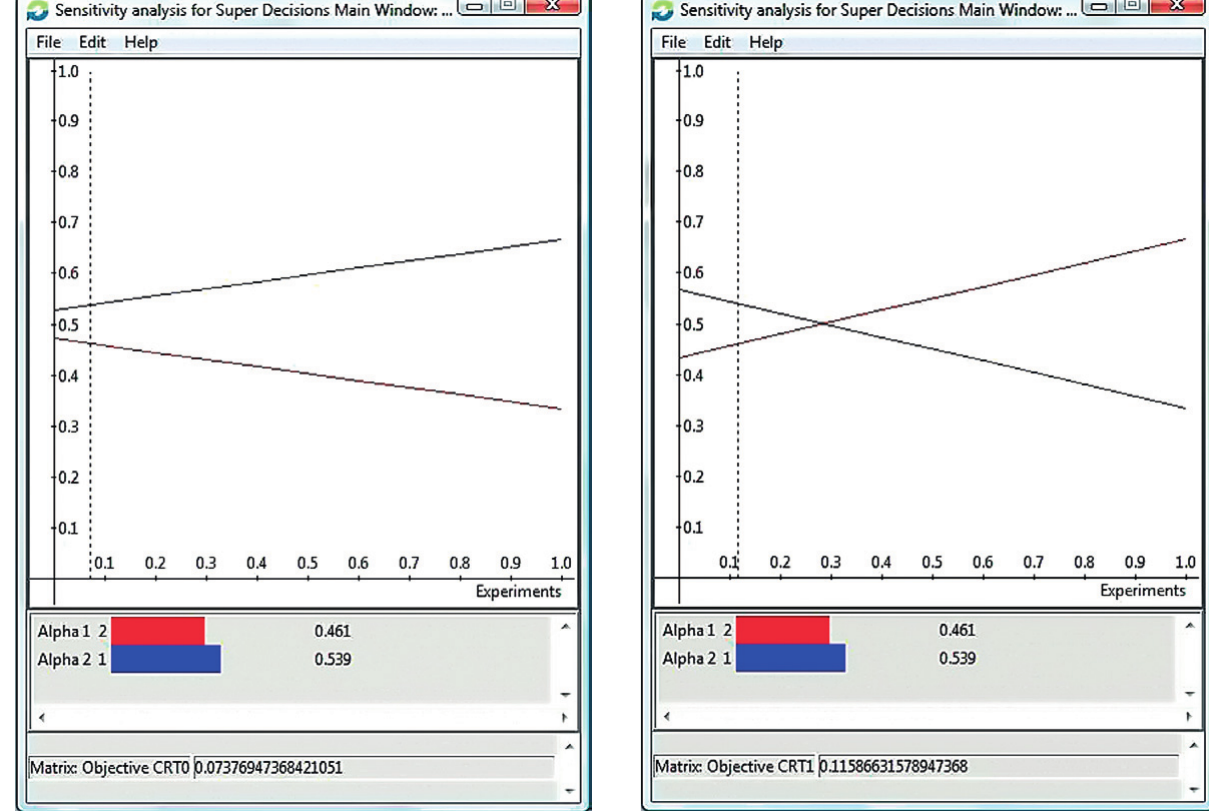
Fig. 5. Sensitivity analysis [CRT07 (left) and CRT12